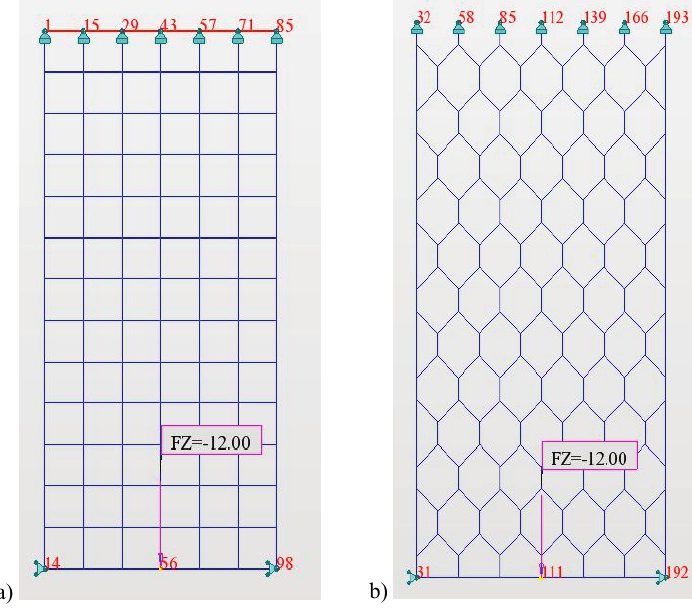
Fig. 4. A scheme of : a) welded mesh load, b) woven mesh